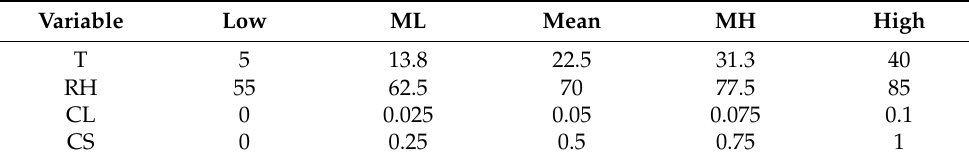
Table 3. Quantities of four input variables.